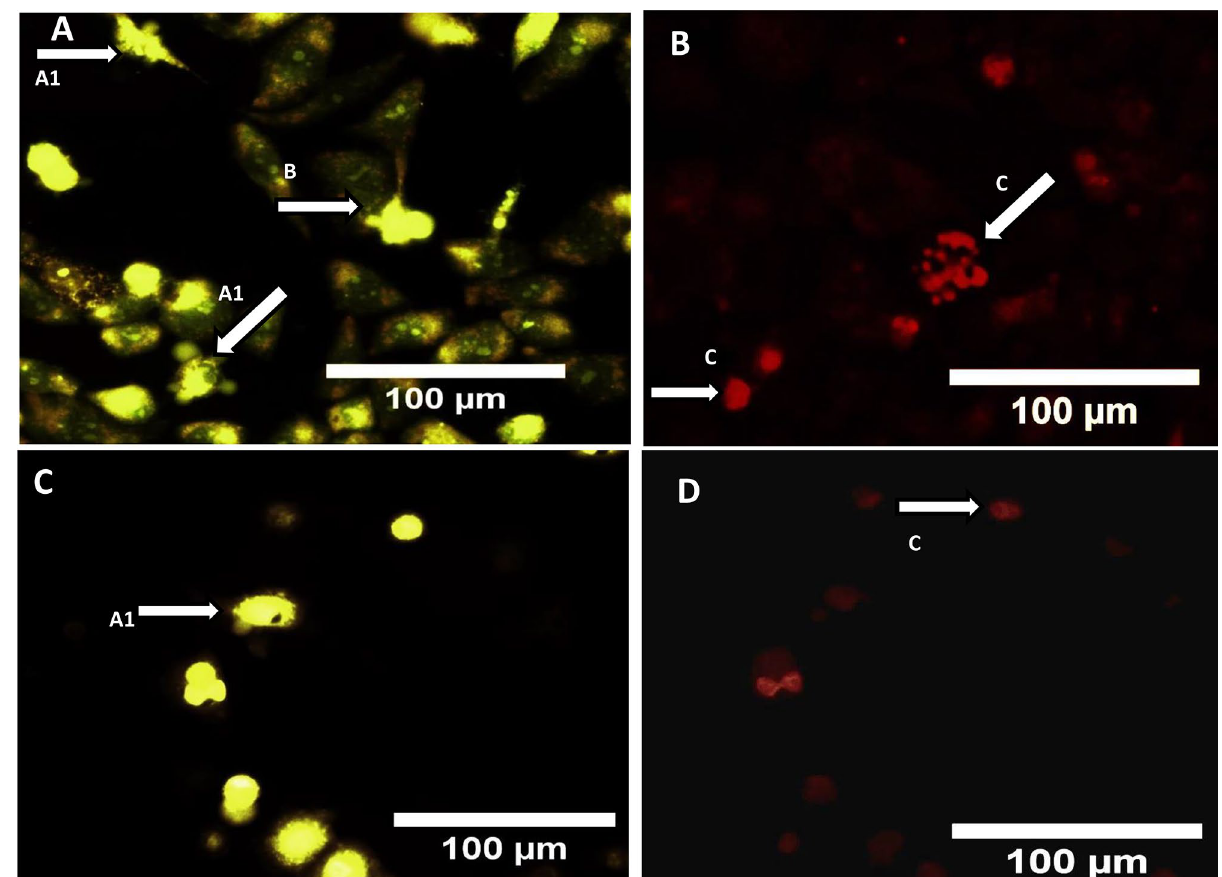
Figure 6. AO/EtBr stained images of ( A , B ) MDA-MB-231 cells treated with curcumin nanoparticle ( C , D ) represents MCF-7 cells treated with curcumin nanoparticle, where ( A1 ) and ( A2 ) membrane blebbing, ( B ) early apoptotic cell, ( C ) fragmented nucleus, ( D ) dead